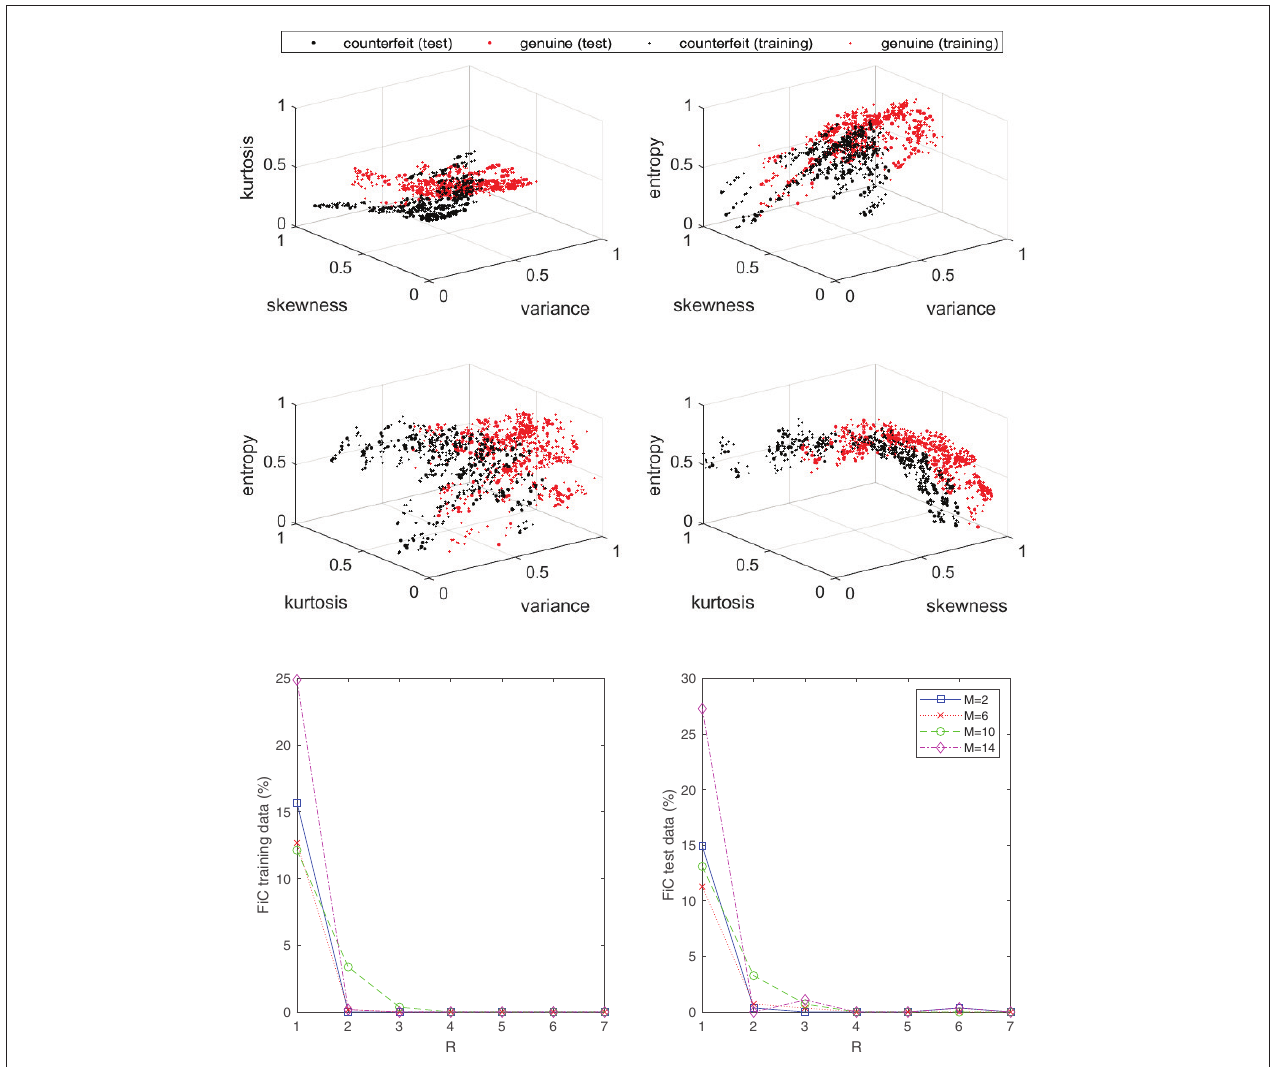
FIGURE 15 | Even though the labeled data of the banknote problem live in a four-dimensional space, the classification problem can still be effectively “solved” with a low-rank classifier (Equation 21). Specifically, as seen in the bottom plot, an R 2 separable expansion is sufficient to obtain a well-performing classifier with marginal = error rates. The top four plots display the labeled data associated with the banknote dataset from the UCI machine learning